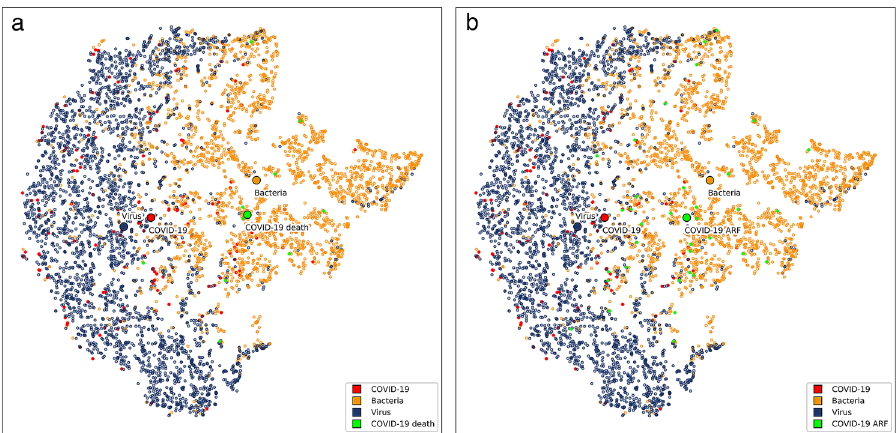
Figure 3. Visualization of bacteria/virus/COVID-19 parameter space with t-SNE method. Each dot represents a patient or more specifically, an embedding of his/her blood parameters into a two-dimensional space, and its color represents the group. Blue dots represent patients with viral infections other than COVID-19, orange dots patients with bacterial infections and red dots patients with COVID-19. Green dots in panel ( a ) represent COVID-19 patients who died (10 patients) and in panel ( b ) COVID-19 patients diagnosed with acute respiratory failure (38 patients). Medoids of bacteria/virus/COVID-19/”COVID-19 death” groups on panel ( a ) and bacteria/virus/COVID-19/”COVID-19 ARF” groups on panel ( b ) are also